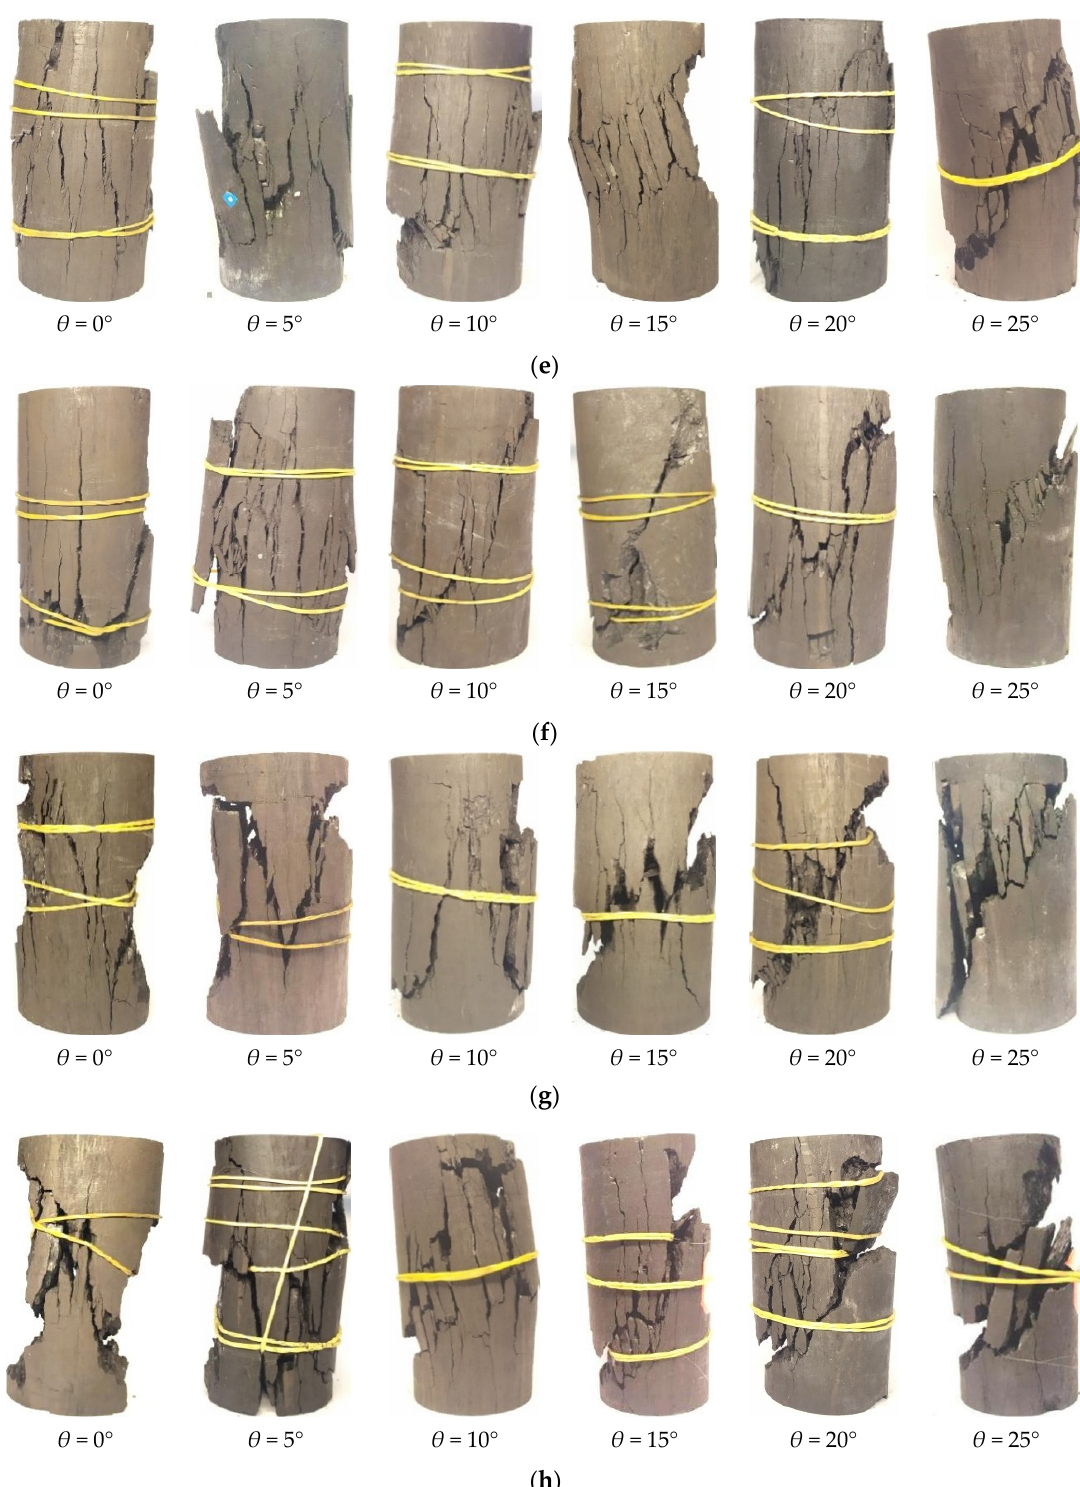
Figure 11. Typical failure coal samples: ( a ) υ = 0.05 mm/min; (b) υ = 0.5 mm/min; ( c ) υ = 1.0 mm/min; ( d ) υ = 2.0 mm/min; ( e ) υ = 3.5 mm/min; ( f ) υ = 5.0 mm/min; ( g ) υ = 7.5 mm/min; ( h ) υ = 10.0 mm/min. Table 4. Failure characteristics of coal samples under various loading rates and inclination angles. Loading Rate Inclination Failure Failure Mode (mm/min) (°) Mechanism